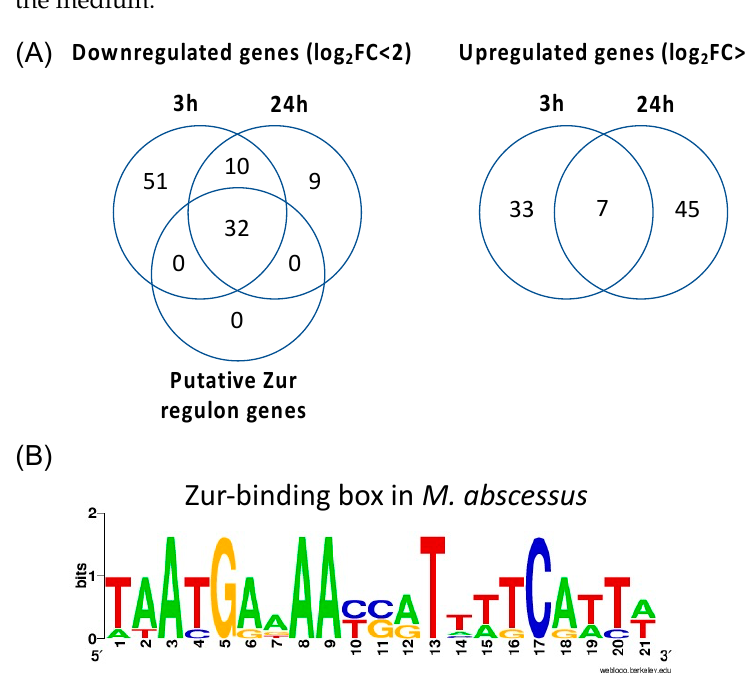
Zur-binding box in M. abscessus